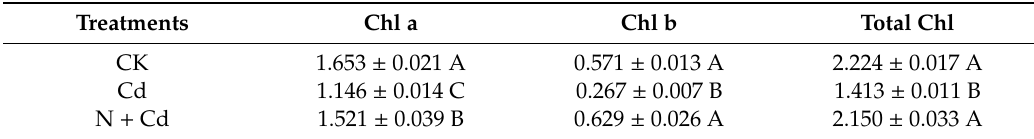
Table 1. Interactive e ff ects of Cd and N treatment on the chlorophyll content in poplar leaves (unit: mg / g FW). Treatments